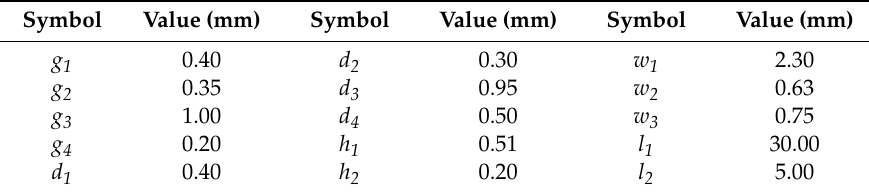
Table 1. Dimensions of the test sets.